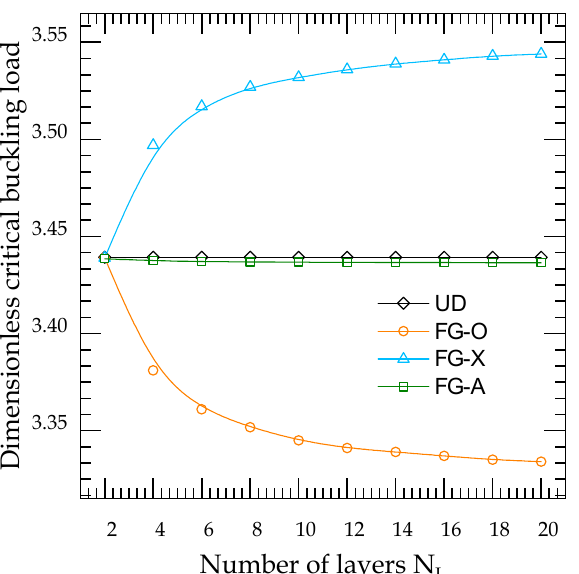
Figure 4. Dimensionless critical buckling load of simply supported GRNC plate in terms of number of layers for various GPLs reinforcement patterns (g (cid:2891)(cid:2900)(cid:2896) ∗ = 1%) .